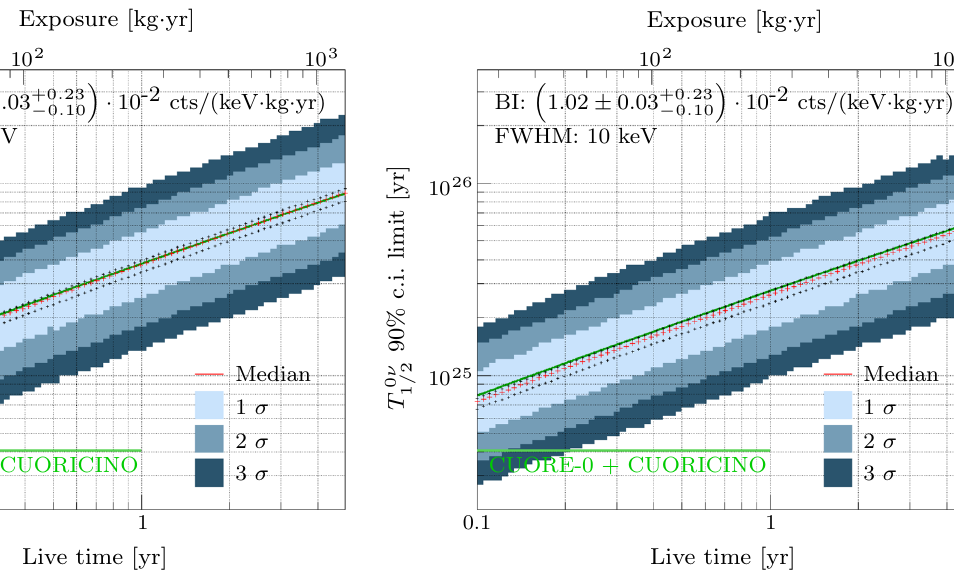
effect on the median sensitivity. The different colored areas depict the ranges containing the 68 . 3, 95 . 5 and 99 . 7% of the toy-MC experiments. They are computed for each live time value separately as described in Fig. 1, bottom . We also show the sensitivity computed as in [19] in dark green . The horizontal green line at 4 · 10 24 year corresponds to the limit obtained with CUORE-0 and Cuoricino [15] 9%